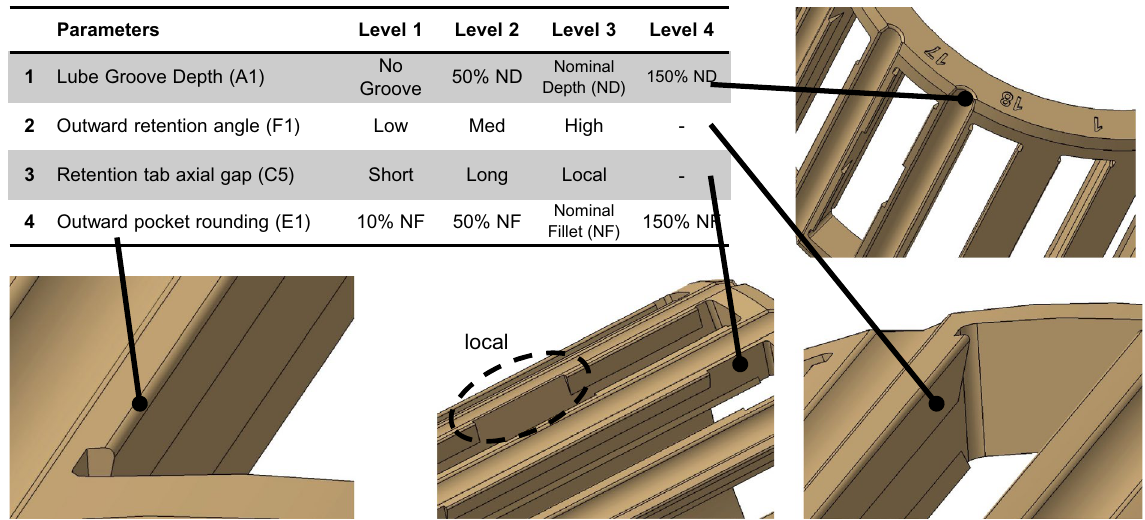
Figure 1. Selected geometrical parameters, their variation levels, and graphical